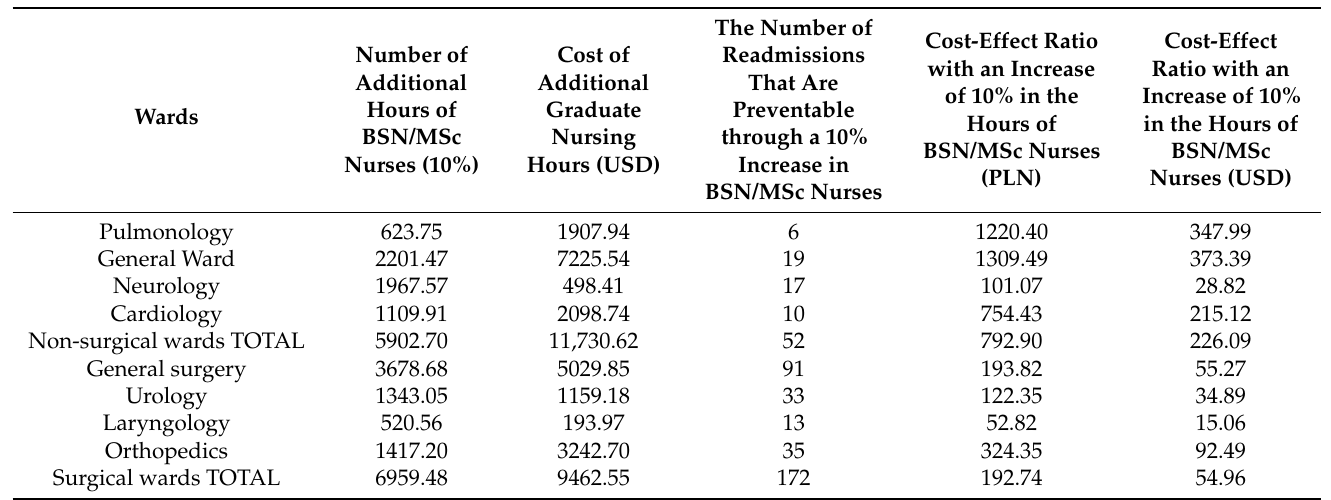
Table 3. The cost-effect ratio concerning nurses’ higher education.